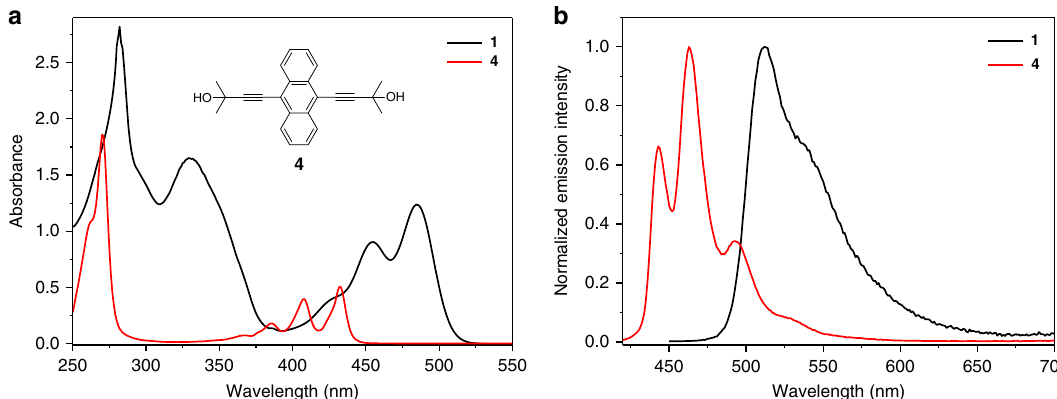
Fig. 2 Spectroscopic characterization of 1 . a UV – Vis and b fl uorescence spectra of 1 and 4 in CHCl 3 (2.00 × 10 − 4 M, λ ex = 425 nm for 1 and 408 nm for